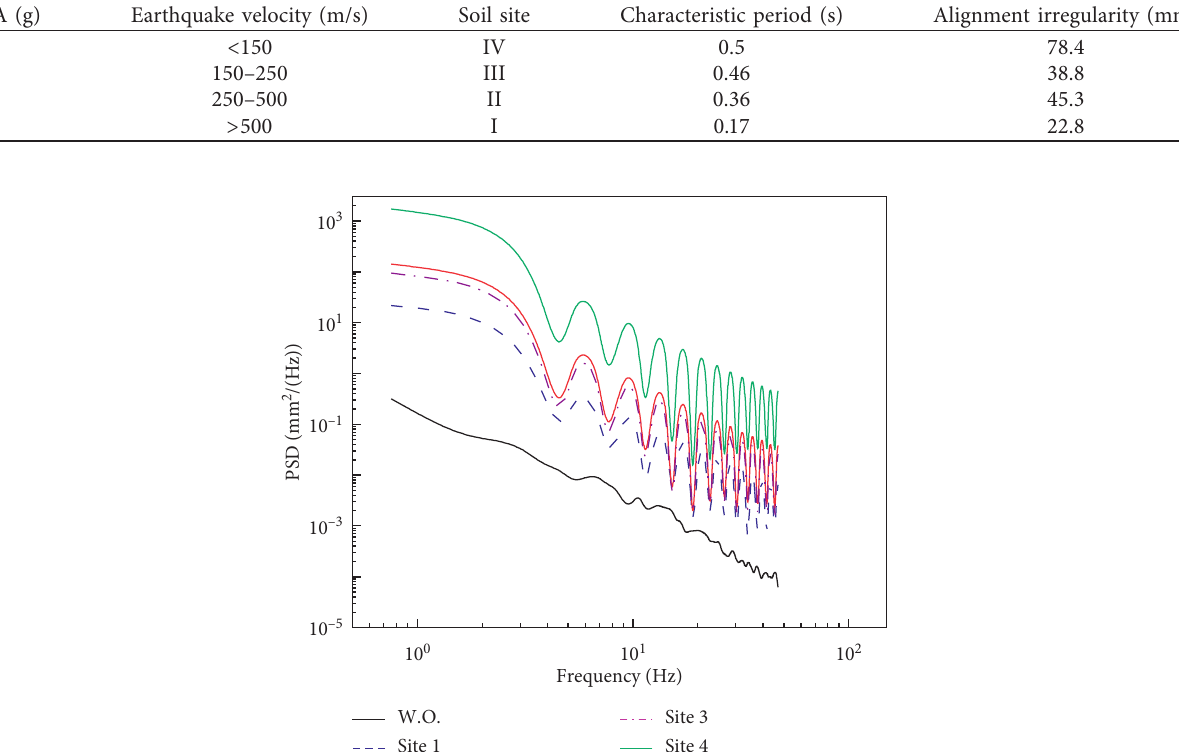
Table 5: The maximum displacement of rail after subjecting to the earthquake excitation with different shear velocities (unit: mm). PGA (g)